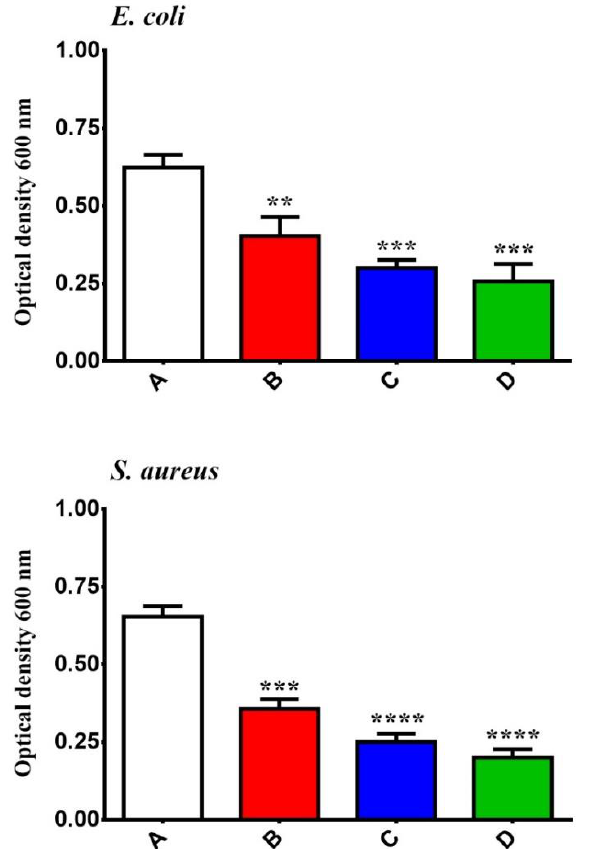
Figure 8. Effect of GONPs, GONPs–PEG and GONPs–PEG– N. stiva in the growth rate of S. aureus and E. coli . cell ( A ), bacterial cells treated with GONPs ( B ), with GONPs–PEG ( C ), and with GONPs–PEG– N. sativa ( D ). The data are shown as the mean ± SD. ** p < 0.01, *** p < 0.001, and **** p < 0.0001.